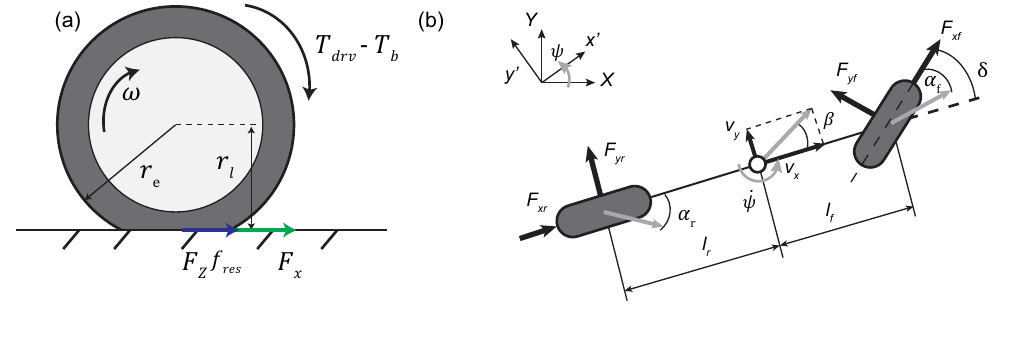
Figure 2. ( a ) Wheel rotating dynamics; ( b ) Single-track vehicle